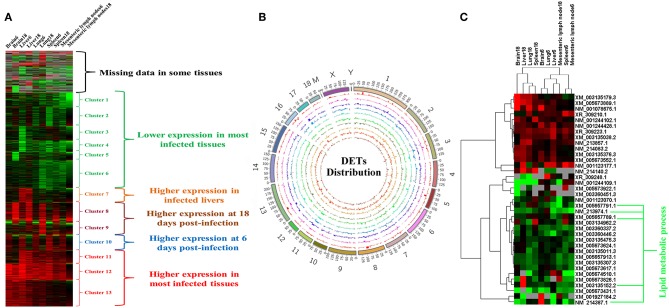
Expression patterns of differentially expressed transcripts (DETs). (A) Cluster analysis of all DETs based on the average values of expression of two replicates. (B) The distribution of DETs across the chromosomes. From outer to inner circle represent chromosomes, DET bar plots of brain6, brain18, liver6, liver18, lung6, lung18, mesenteric lymph nodes6, mesenteric lymph nodes18, spleen6, and spleen18, respectively. (C) Clustering of DETs encoded by X chromosome. Red, green, and gray colors represent upregulated, downregulated and missing (undetected) data, respectively.